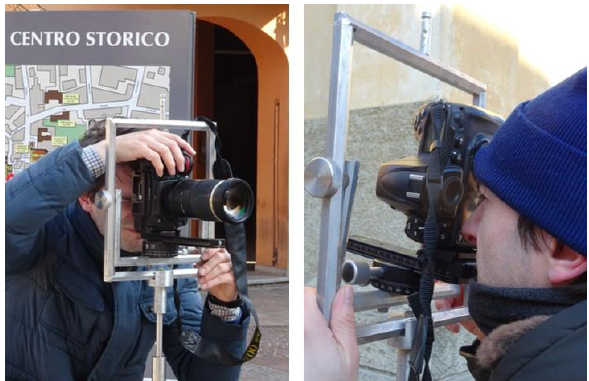
Figure 8. The cardan joint based rotating camera